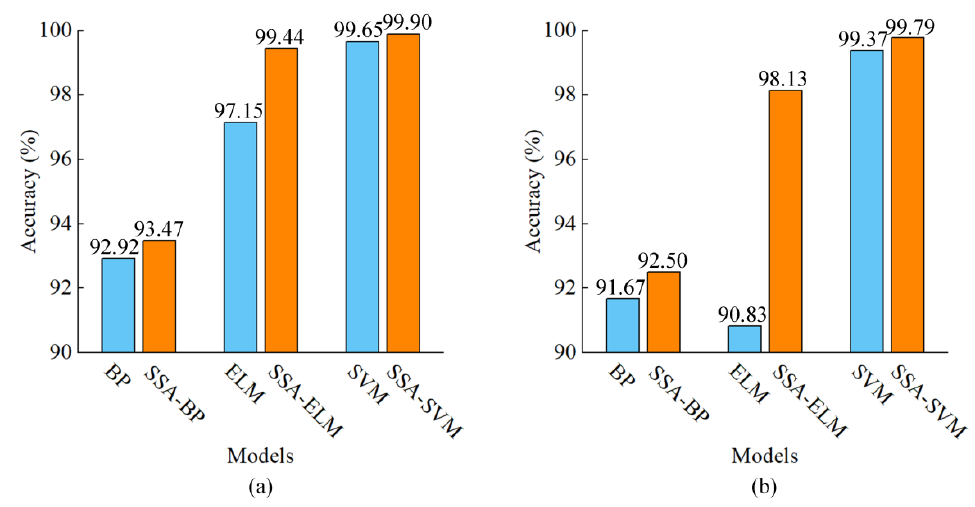
Figure 3. Comparison for accuracy of models in each data set. ( a ) Calibration set (10-fold cross- validation); ( b ) prediction set. BP: back propagation neural network; ELM: extreme learning machine; SVM: support vector machine; SSA: sparrow search algorithm.